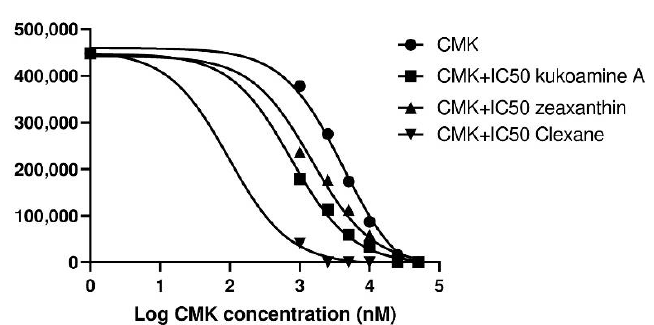
Figure 2. Adjuvant inhibition of physiological furin using CMK in combination with Clexane, Kukoamine A, or Zeaxanthin. mRFU/min : millirelative fluorescence units/minute; Log : decimal logarithm.